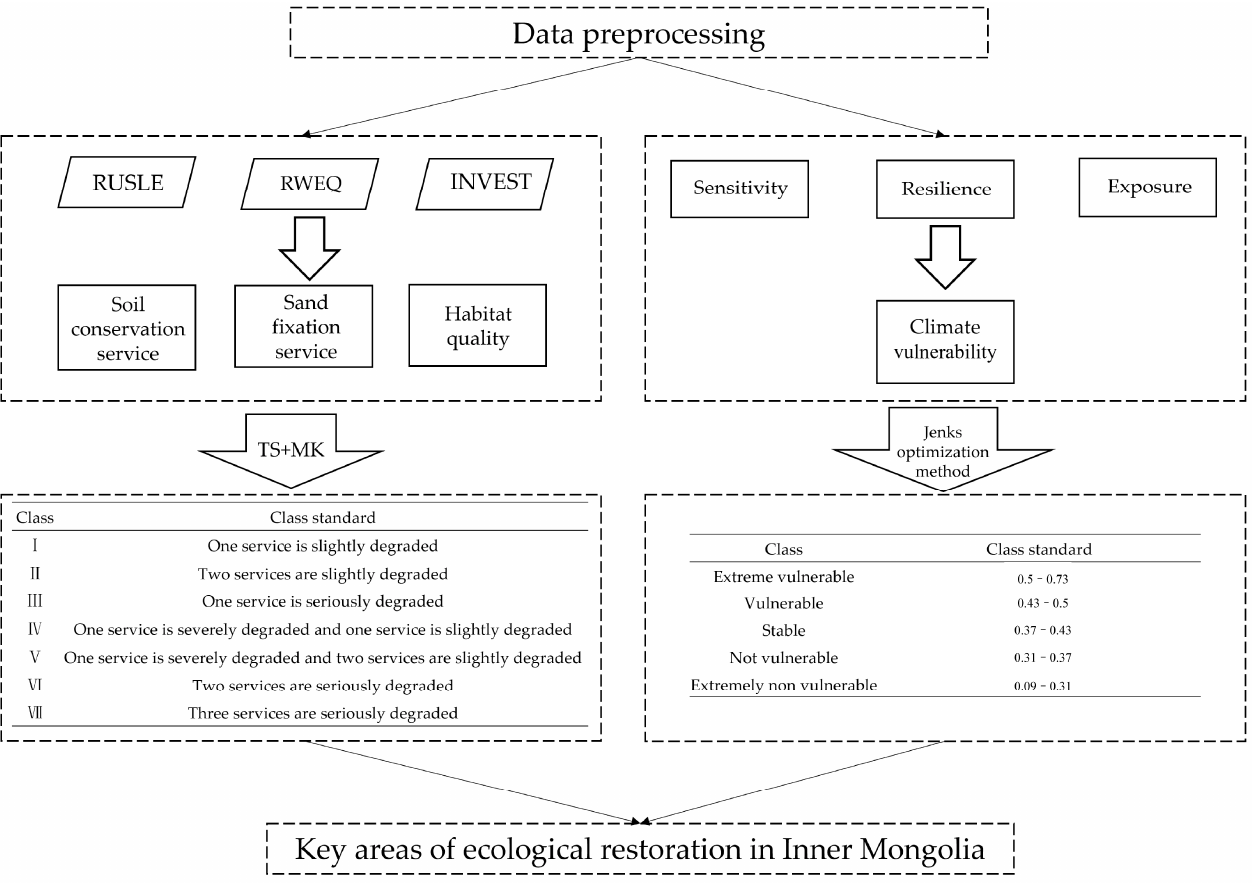
Figure 2. Key restoration areas framework. The first step is data processing, the second step is calculating ecosystem services and ecosystem vulnerability, the third step is classification, and the last